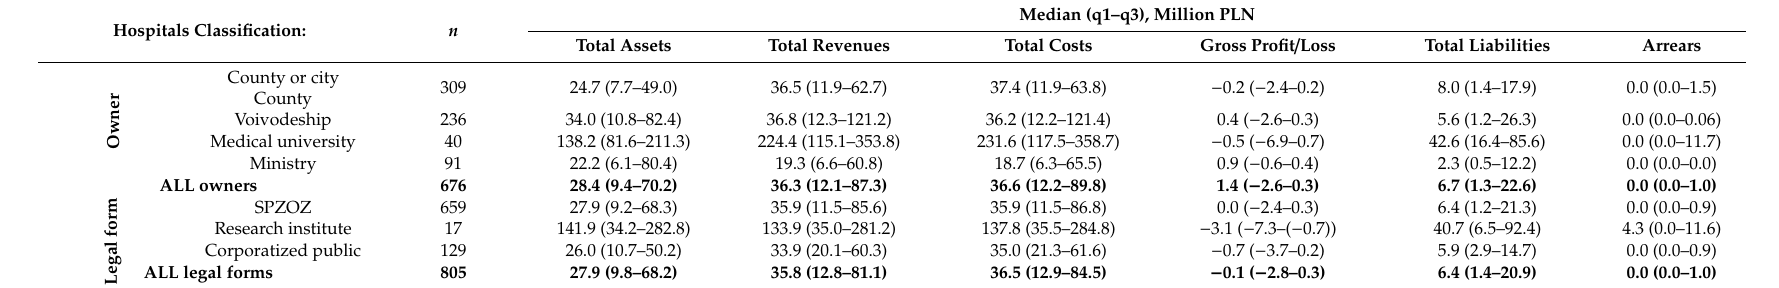
Table 2. Median values of basic financial variables per hospital groups (million PLN, 2018).